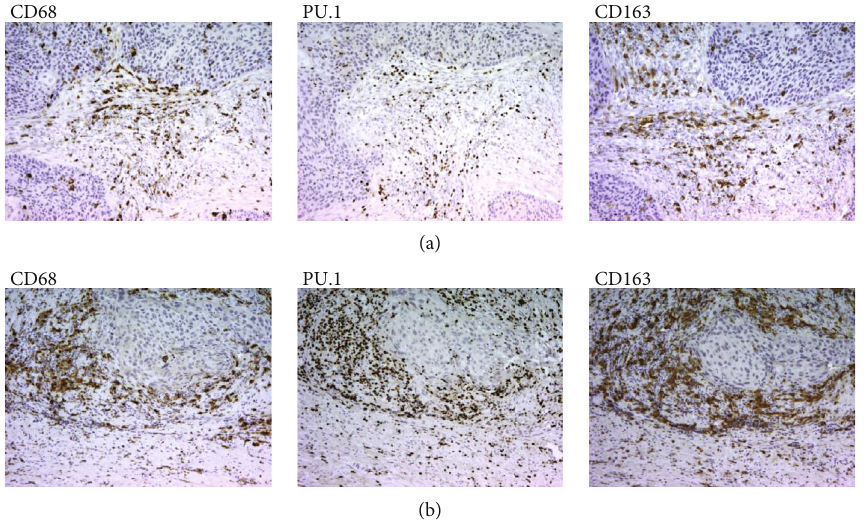
Figure 3: Immunohistochemical analysis of CD68, PU.1, and CD163 on serial tissue sections of 2 di ff erent tissue samples (magni fi cation